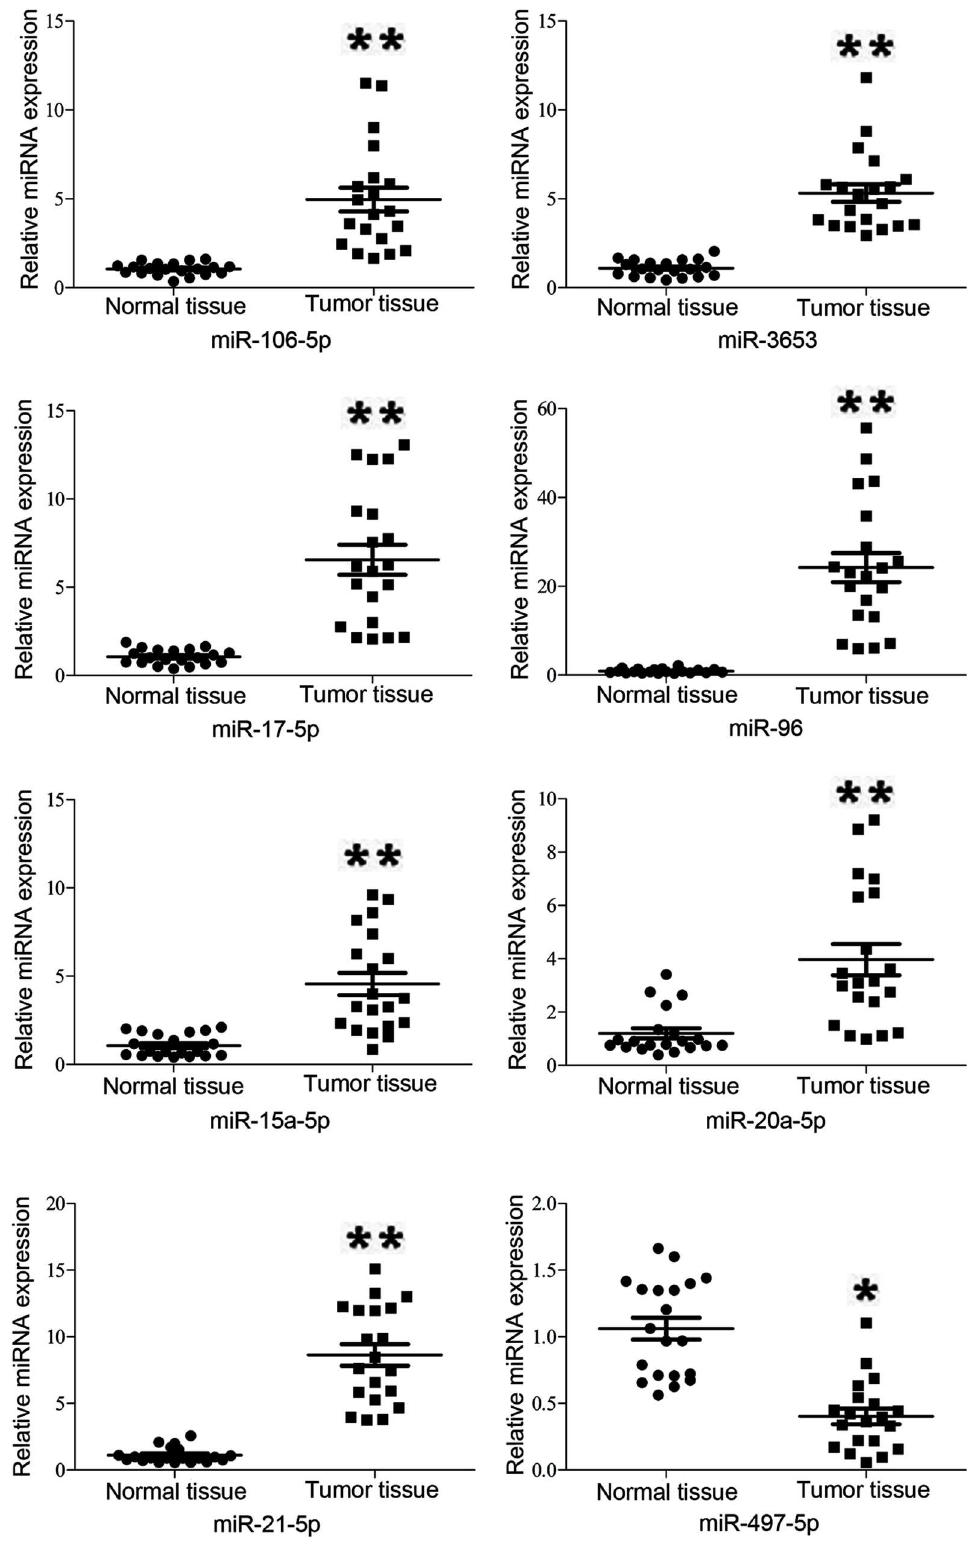
Fig 3. Relative quantification of differentially expressedmiRNAs in 20 cervical cancer and 20 normal cervical tissues. qPCR analysiswas performed in three separate experiments ( * p < 0.05; ** p < 0.01).